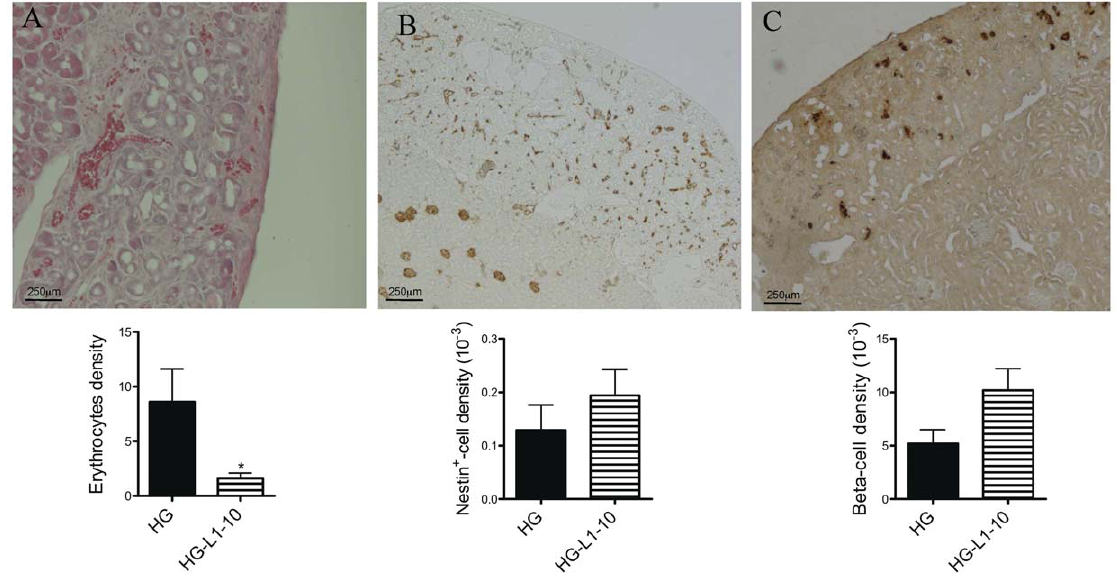
Figure 6. L1–10- induced specific Ang2 inhibition in hyperglycaemic conditions. During the 2 weeks post-graft, STZ-induced diabetic SCID mice received L1–10 (4 mg/kg, twice-a-week). Pancreata were then collected (A) and vascularization was analyzed by hematoxylin-eosin staining (B) and nestin immunohistochemistry (C). Large blood-filled spaces were decreased by L1–10 treatment (E). Insulin staining (G) showed a trend towards increased b -cell density by L1–10 treatment.